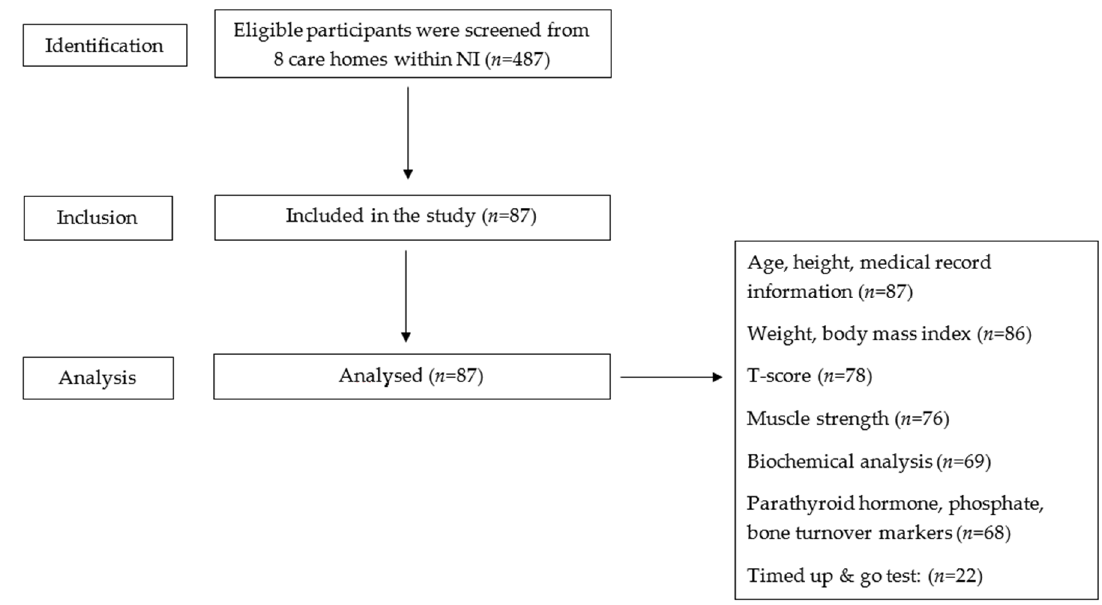
Figure 1. Strobe flow diagram of observation study.